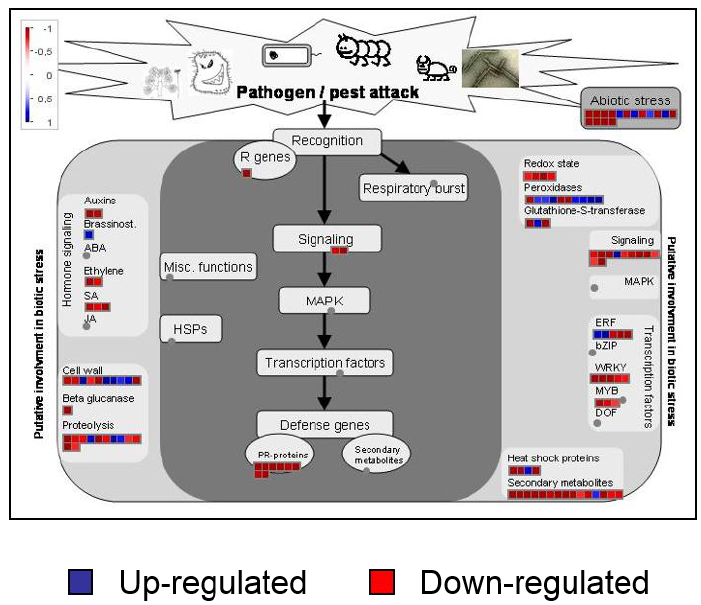
Figure 3. MapMan visualization of defence-related differentially expressed genes in response to MeJA in control or C2-TS-expressing plants.